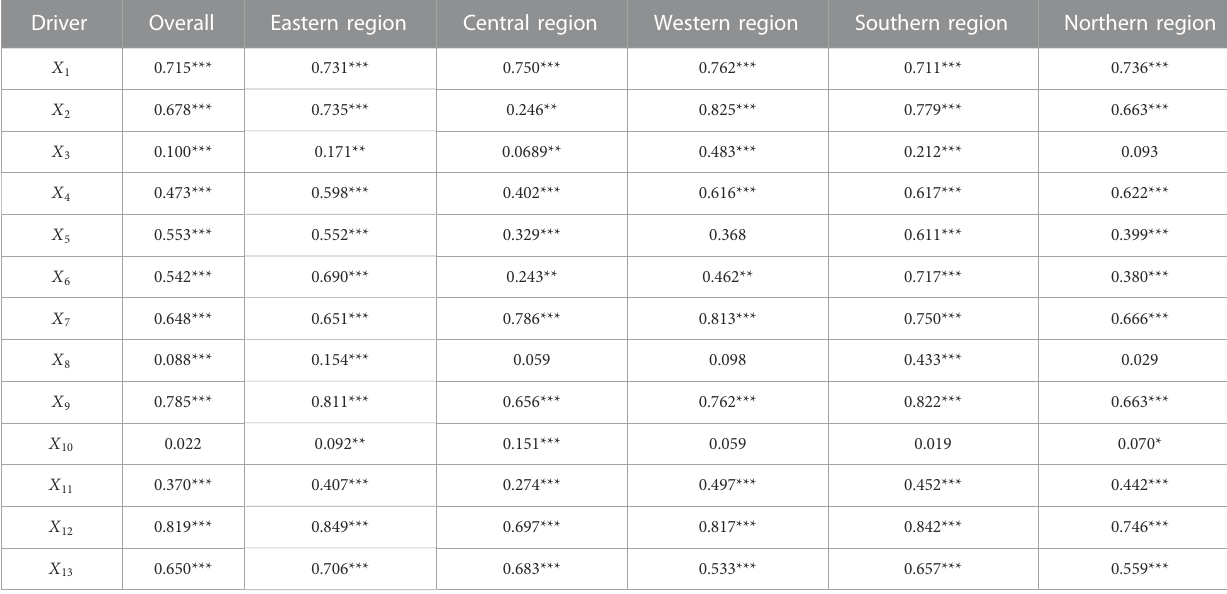
TABLE 4 Drivers of spatial divergence of economic resilience in Chinese cities.